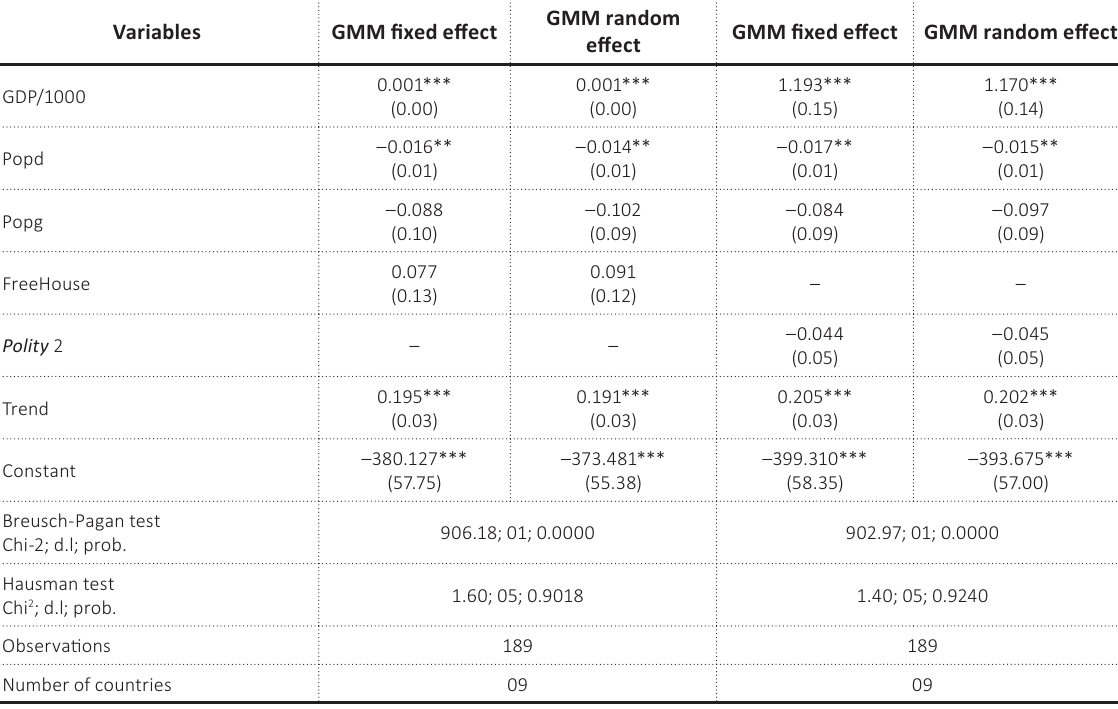
Table 2. Relation between economic growth and protected areas in the Congo